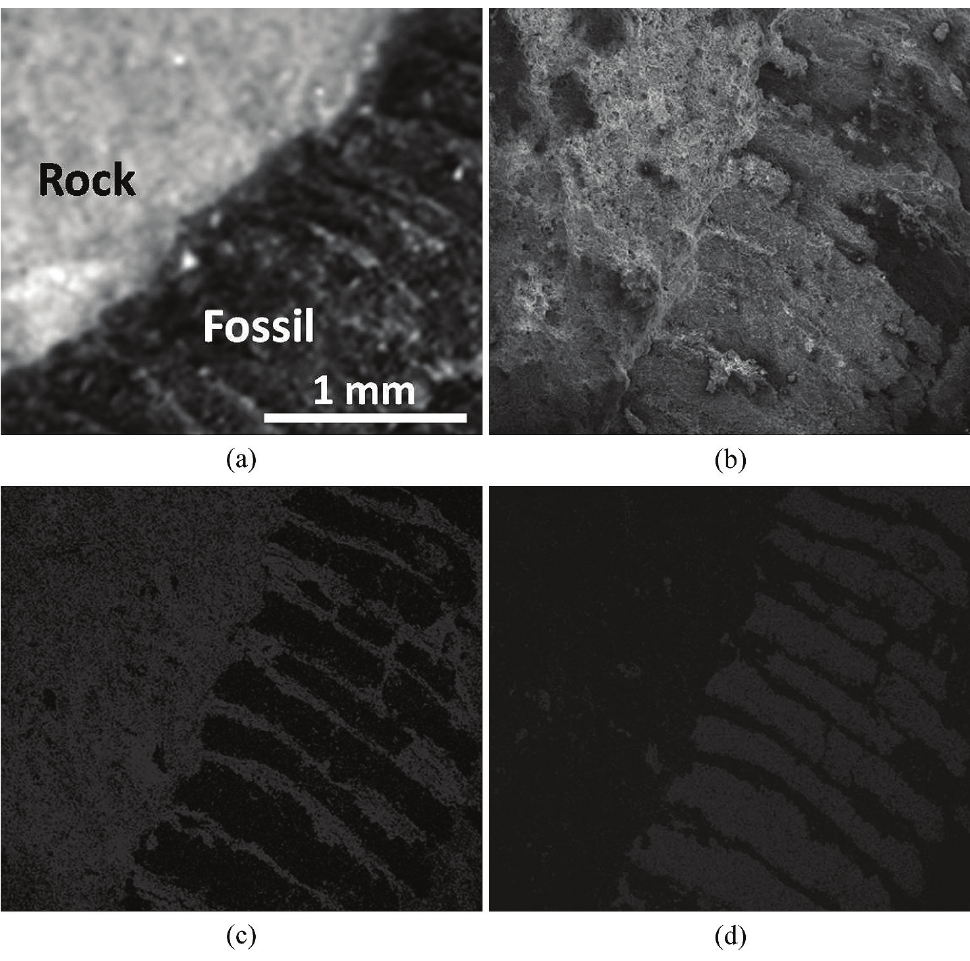
Figure 4. SEM/EDX analysis of Corumbella werneri : (a) Image of the analyzed portion of carapace and rock matrix. The scale in photograph refers to the all four images. (b) SEM micrograph of fossil and rock; (c) EDX map of the distribution of Fe on the sample; (d) EDX map of the distribution of Ca on the sample. For the figures (c) and (d), the lighter spots indicate higher concentration of elements, while the dark regions indicate the absence of the element.